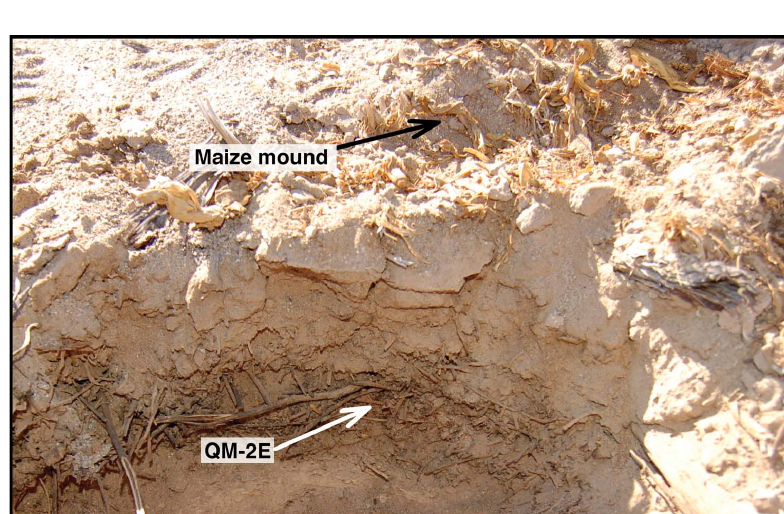
Fig. A4. Maize ( Zea mays ) litter (QM-2A) found in situ upon the QM-2E subsurface